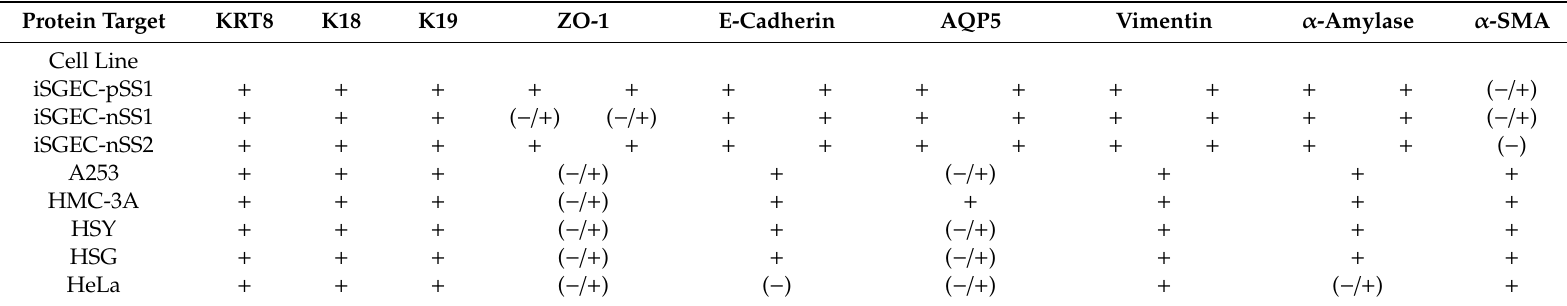
Table 2. Immortalized salivary gland epithelial cells (iSGECs), salivary gland cell lines (SGCLs), and HeLa protein expression of characterization markers by immunocytochemistry